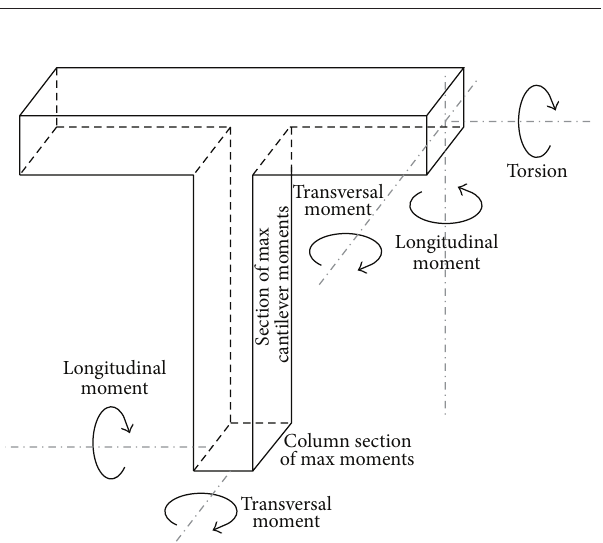
Figure8:Schematicplotoftheconsideredpiersectionsandinternal